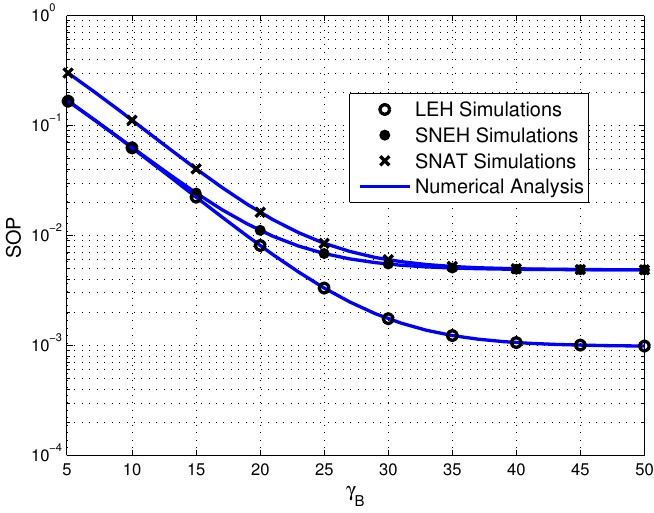
Figure 8. Secrecy outage probability versus γ P under three EH modes, where τ = 20